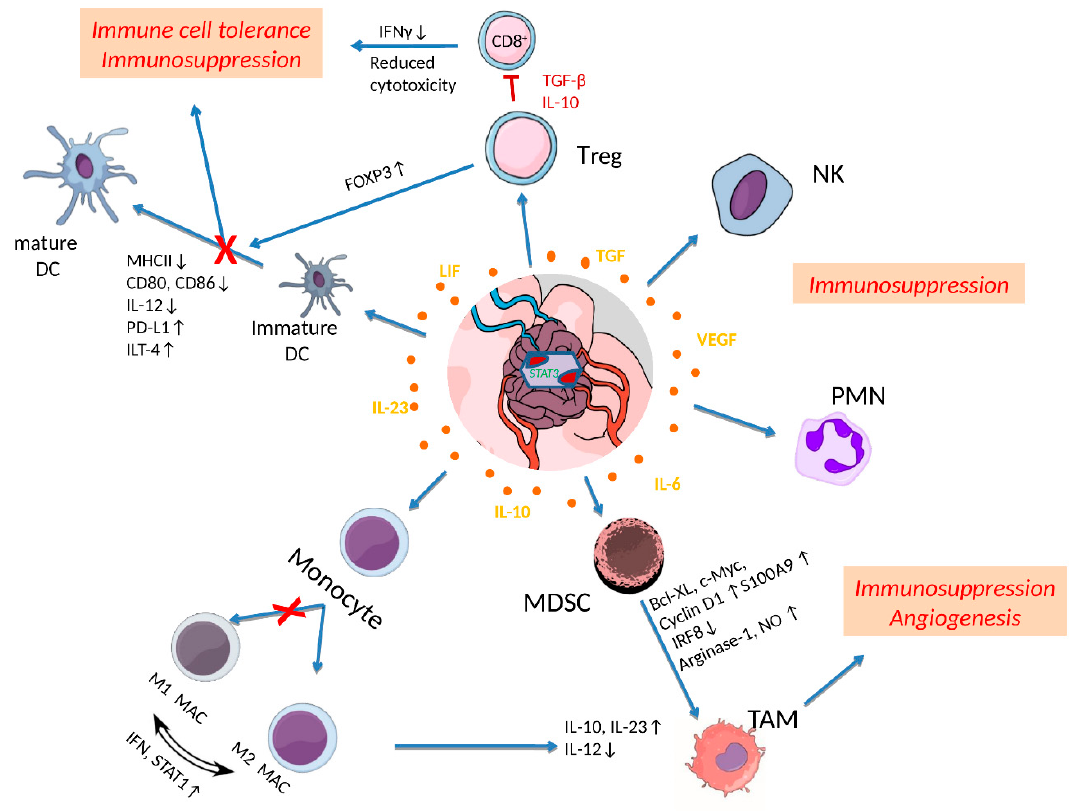
Figure 2. E ff ects of STAT3 activation in shaping tumor microenvironment (TME) in glioblastoma (GB). CytokinesreleasedbytumorandinflammatorycellsupregulateSTAT3, whichfurthera ff ectsimmunecell activities in TME. Activated STAT3 in regulatory T cells (Treg) induces the transcription of IL-10, TGF- β and FOXP3 levels that restrain CD8 + e ff ector T cell activity and dendritic cell (DC) maturation leading to immune cell tolerance and immunosuppression. STAT3 activation is also reducing the expression of MHC II, IL-12, CD80, CD86 and ILT-4 to directly inhibit DC maturation processes. Furthermore, elevated pSTAT3 levels dysregulate the polarization of M1 to M2 macrophages (M1 MAC / M2 MAC), maintaining and increasing M2 tumor associated macrophages (TAMs). Myeloid-Derived Suppressor Cells (MDSCs) exhibiting increased STAT3 activation are further expanded though upregulation of c-Myc, BCL-X L , cyclin D1, and S100A9, di ff erentiate into TAMs and promote angiogenesis. Finally, constitutive activation of STAT3 in neutrophils (PMN) and natural killer (NK) cells inhibits their tumor killing activity leading to immunosuppression. Reproduced / adopted in modified form from